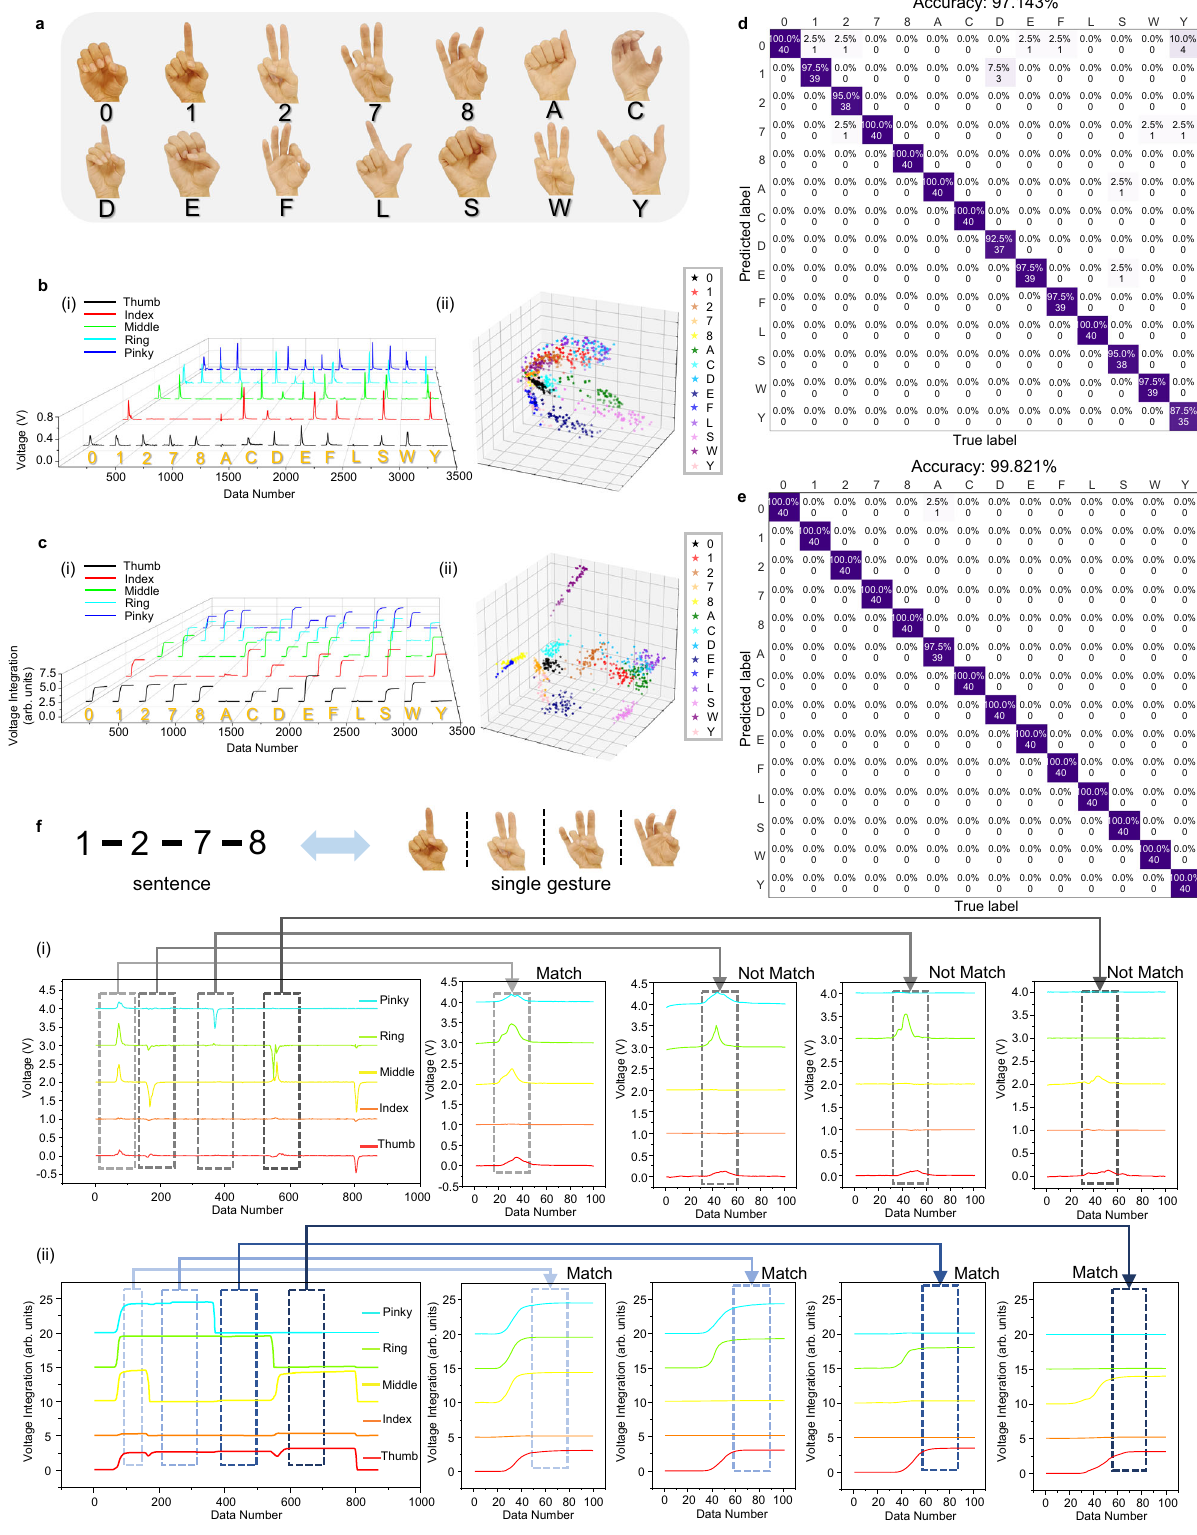
Fig. 3 | ML-enabled gesture/sign language recognition system enabled by the ATH-Ring. a Illustration of the 14 American sign language gestures for further recognition. b The (i) pulse-like signals (ii) and the corresponding PCA clustered results for 14 gestures. c The (i) voltage integration signals (ii) and the